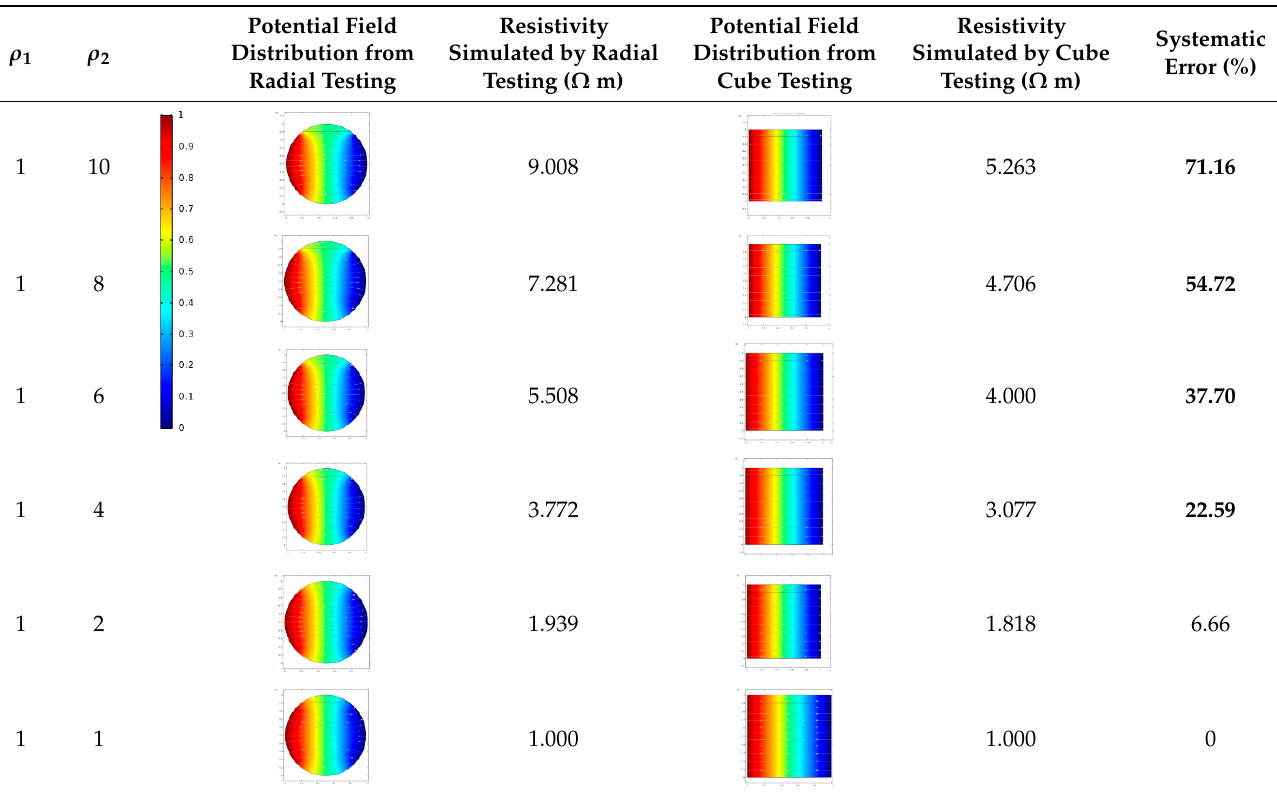
Table 7. Numerical simulation results for resistivity difference in various materials (0.1:0.9).